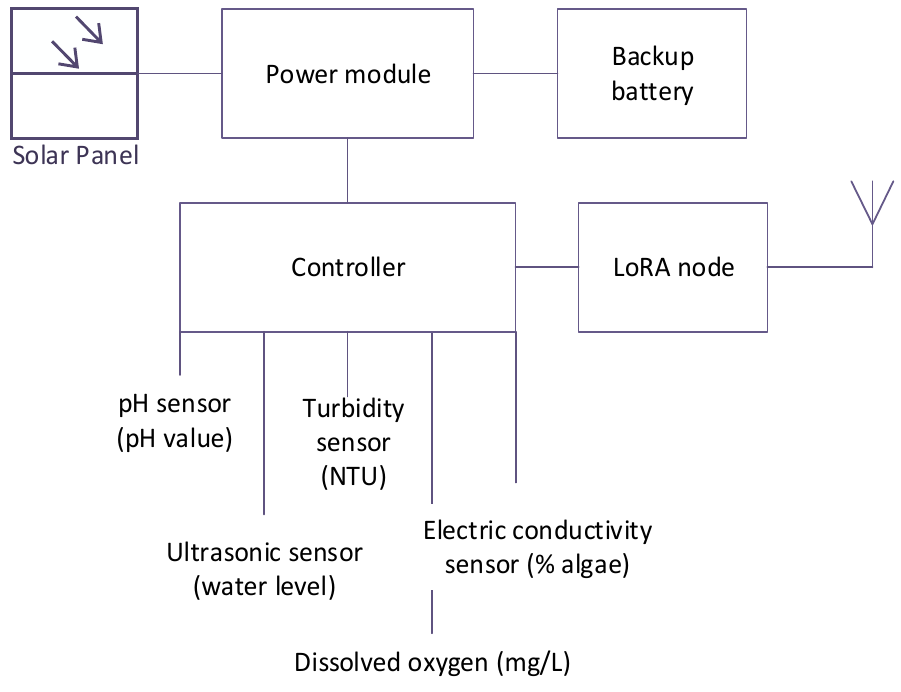
Figure 2. Overview of sensors and hardware for the water quality monitoring system. The utilized water sensors can sense five water quality parameters, including an ultra- sonic sensor (to measure water level), pH sensor (to measure acidity/alkalinity), dissolved oxygen sensor, turbidity sensor (to measure water clarity), and electrical conductivity (EC) sensor (to measure the presence of algae). Figure 3 depicts the layout and the developed water quality monitoring